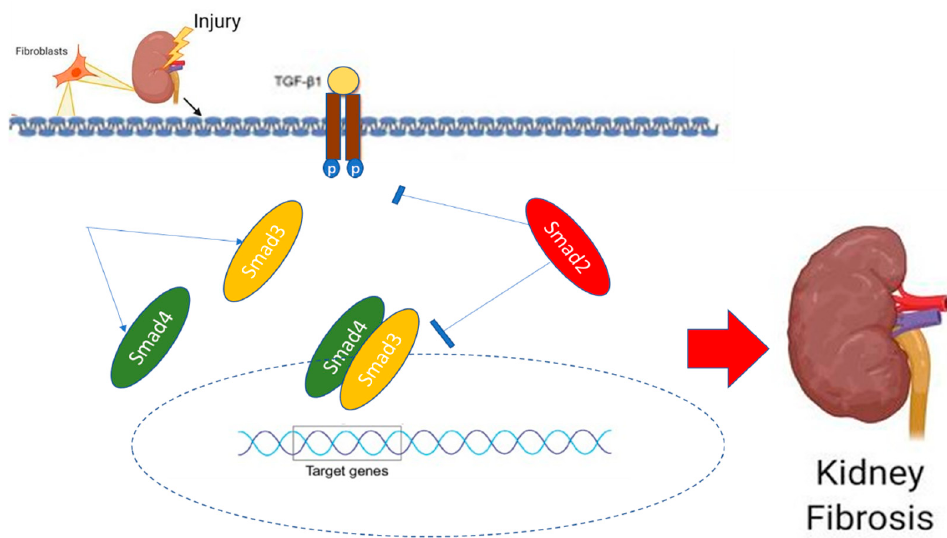
Figure 13. The activation of the Smad2, 3, and 4 complexes by TGF- β cause pro-fibrogenic genes to be induced, which in turn causes the fibrosis